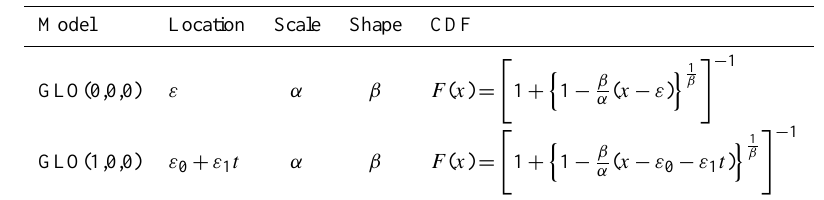
Table 1. Stationary and nonstationary generalized logistic